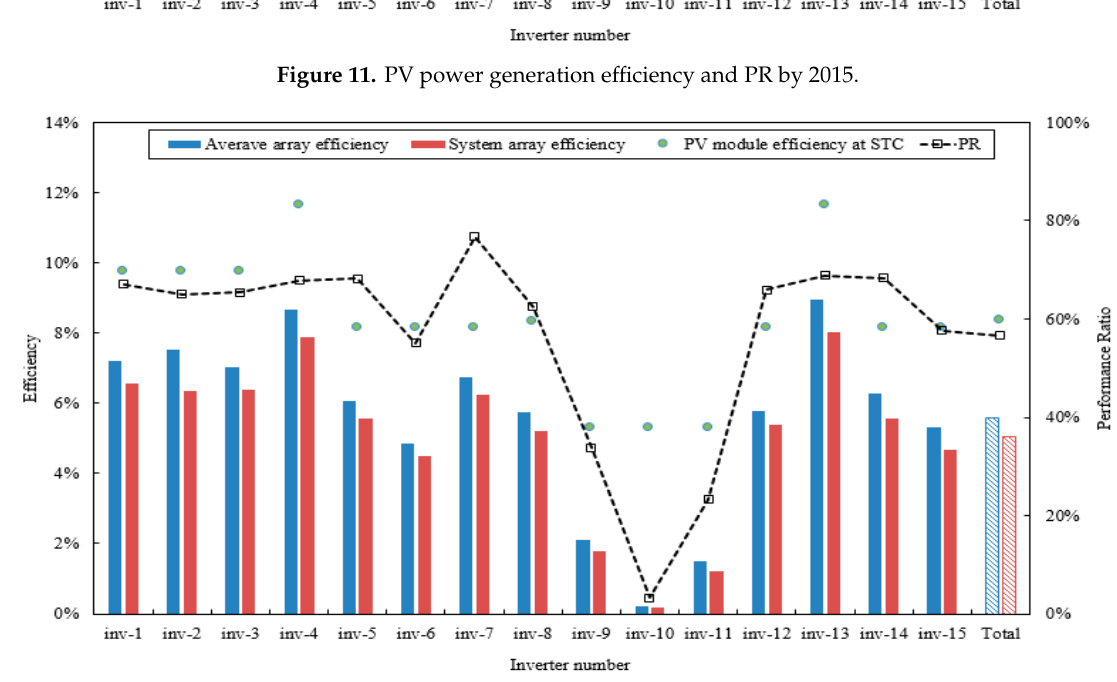
ffi ciency and PR by Figure 12. PV power generation efficiency and PR by 2016. Figure 12. PV power generation e Figure 12. PV power generation efficiency and PR by 2016.